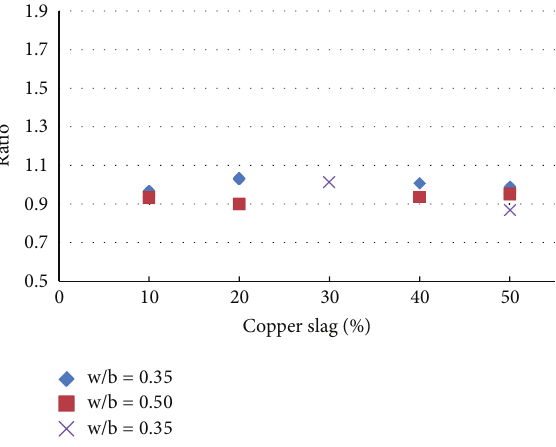
Figure 13: Results of experiment with no